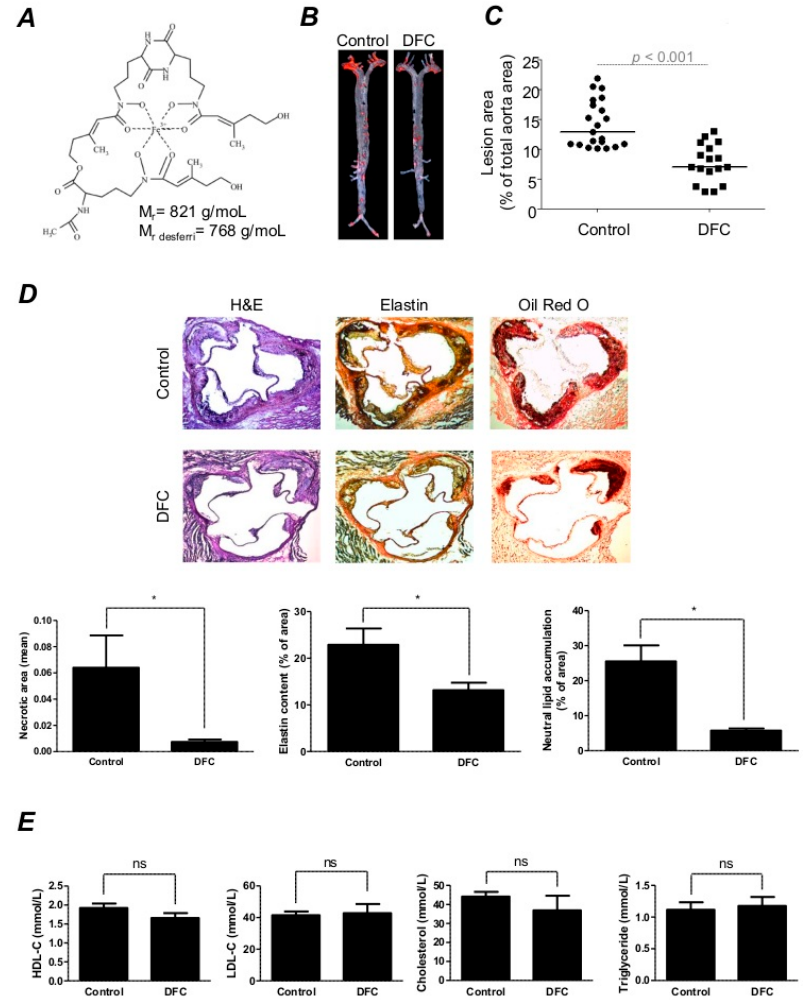
Figure 1. Intraperitoneal administration of desferricoprogen (DFC) attenuates atherosclerosis in mice. Eight-week-old Apolipoprotein-E-deficient (ApoE − / − ) mice were fed ad libitum with an atherogenic diet containing 5% fat and 1.25% cholesterol and divided into DFC group ( n = 17) receiving 160 mg / kg intraperitoneal DFC and control group ( n = 21) receiving physiological saline every second day for 8 weeks. ( A ) Molecular structure of the coprogen. ( B ) Atherosclerotic lesions were examined by Oil Red O staining of en face aortas derived from DFC-treated or control mice. Scale bar: 1 mm. ( C ) Quantitative analysis of atherosclerotic plaque burden in Oil Red O-stained aortas using Image J software. ( D ) Immunohistochemical analysis of aortic cryosections (6 µ m) derived from control and DFC-treated mice stained for Hematoxylin-Eosin (first row), Elastin (second row) and Oil Red O (third row) was performed with Image J software. Scale bar: 0.2 mm. ( E ) Quantitative analysis of plasma high-density lipoprotein-cholesterol (HDL-C), low-density lipoprotein-cholesterol (LDL-C), cholesterol and triglycerides levels of control and DFC-treated mice on an atherogenic diet. The graph shows the mean ± SEM of 6 mice plasma cholesterol levels per group. * p < 0.05; ns: not